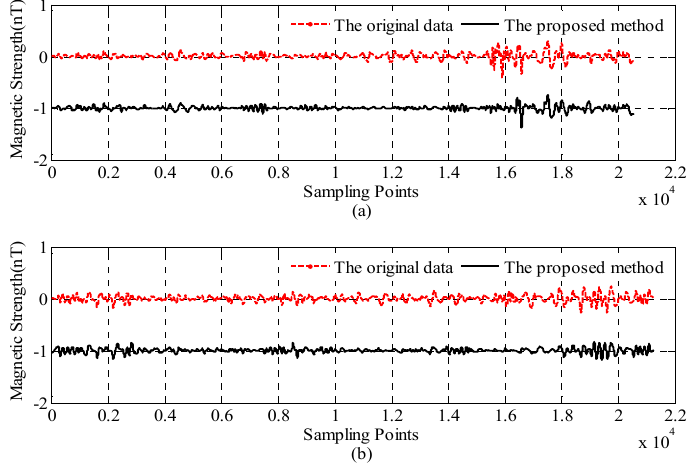
Figure 7. The interference field before and after the CNS method: ( a ) calibration flight and ( b ) test flight. The quantitative comparisons of before and after the proposed CNS method are presented in Table 4. The proposed CNS method can improve the compensation performance by about 30% compared to the traditional